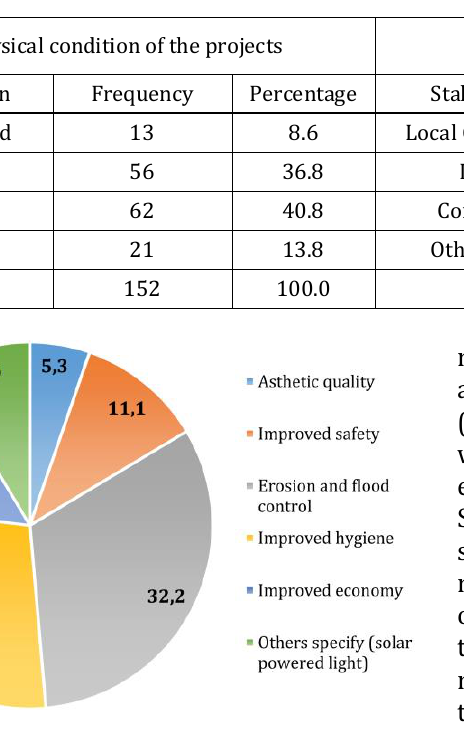
Fig. 6. Residents benefits of the LEEMP